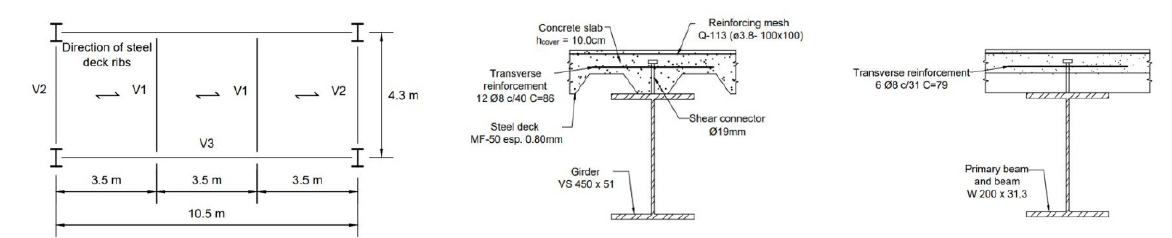
Figure 8. Geometry of the floor system from example